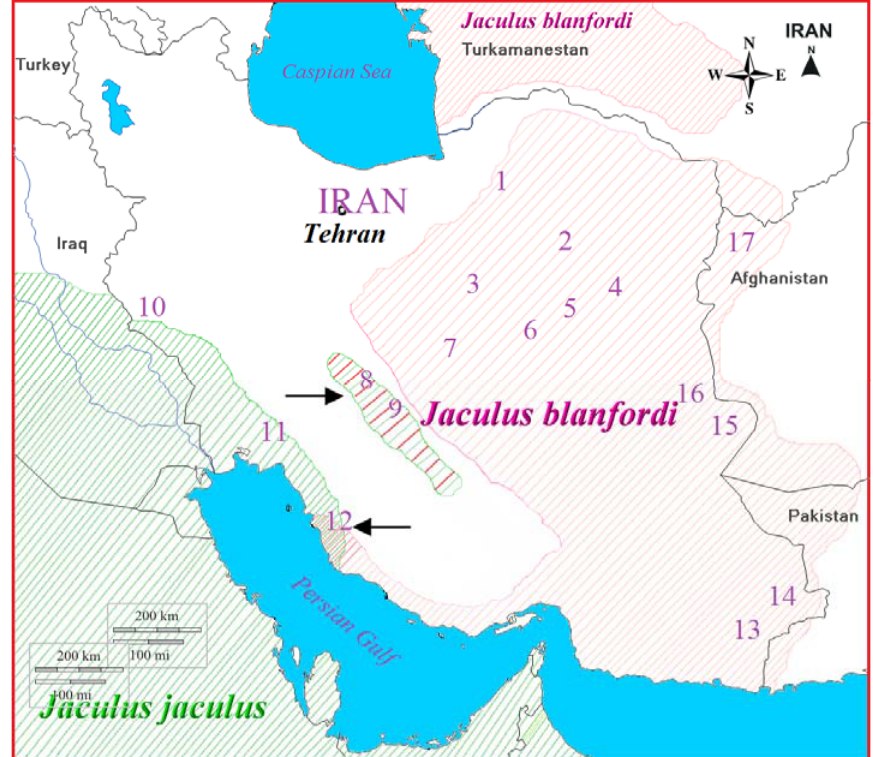
F IGURE 1 . The map of the locality that samples were captured (1-Jajaram, 2-Kashmar, 3-Bajestan, 4- Gonbad, 5-Ferdows, 6-Tabas, 7-Yazd, 8-Esfahan, 9-Kavire-Mesr, 10-Ilam, 11-Khuzestan, 12- Bushehr, 13-Saravan, 14-Khash, 15-Daghal, Zabol, 16-Nehbandan, 17- Harat, Afghanistan) and the distribution areas of J. jaculus and J. blanfordi in Iran. Arrows indicate locations of presence of both species.